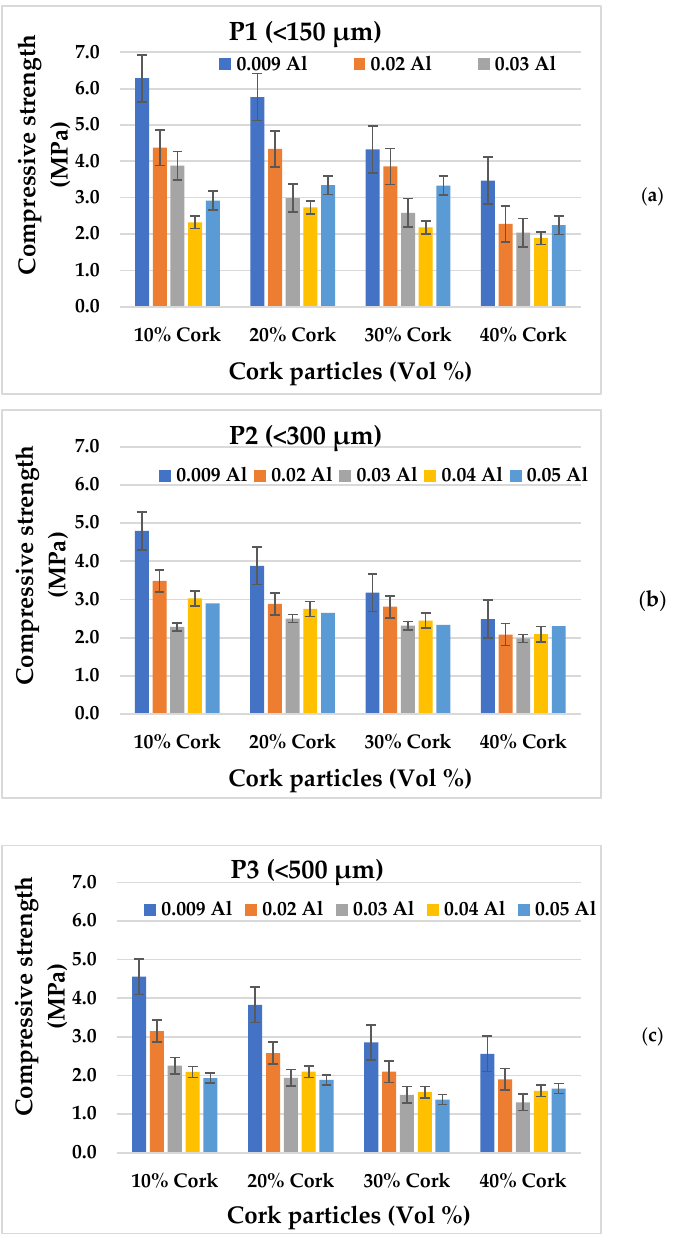
Figure 2. Compressive strength results versus cork particles percentage with different amounts of Al powder at 28 days; ( a ) P1 (<150 µm), ( b ) P2 (<300 µm), and ( c ) P3 (<500 µm).